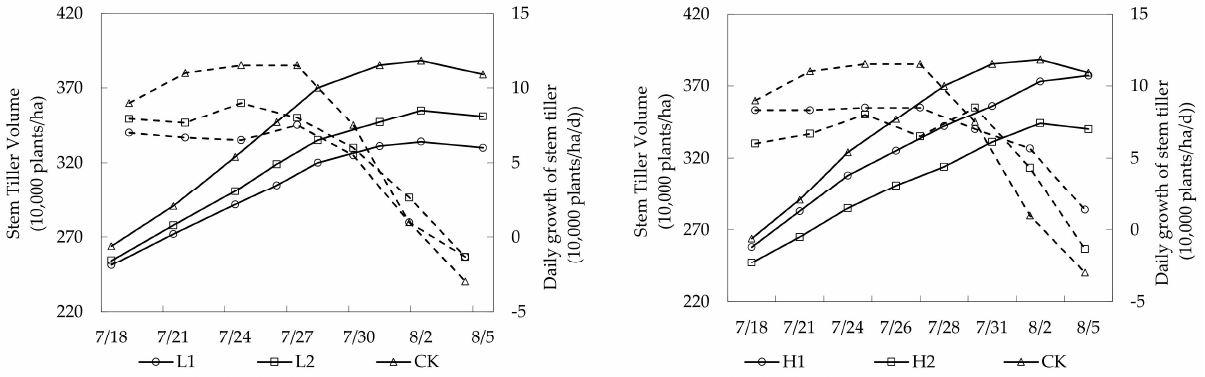
Figure 2. Figure 2. Dynamics of rice stem tiller volume and daily growth during tiller stage water level management.